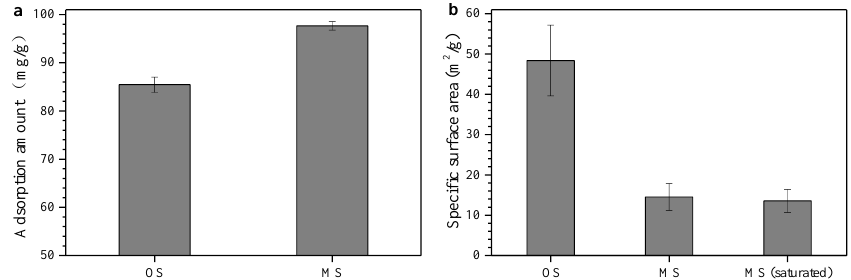
Figure 2. Comparison of MG adsorption amount ( a ) and specific surface area ( b ) of different adsorbents. In the abscissa label, PAC represents powder activated carbon, OS represents original sepiolite, MS represents modified sepiolite, and MS (saturated) represents the modified sepiolite after adsorption saturation.